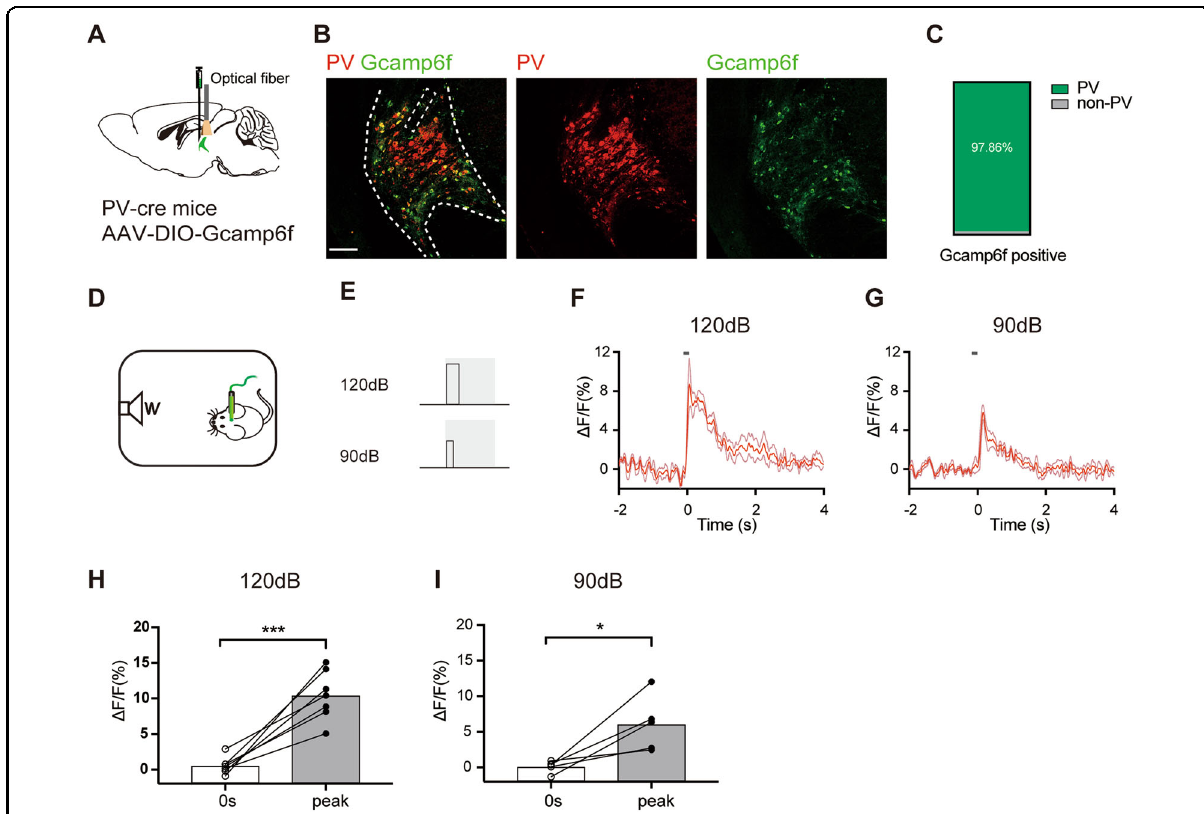
Fig. 2 Sound stimuli of PPI paradigm increases calcium activity of PV + neurons in audTRN. A Strategy of calcium activity recording of PV + neurons in audTRN. A Cre-dependent AAV for expression of Gcamp6f was bilaterally injected into the audTRN in PV-cre mice. B Left, example of confocal image showing overlap of Camp6f + neurons (green, right) and PV + neurons (red, middle). White dotted lines mark the border of the audTRN. Scale bar: 100 µm. C Quanti fi cation shows that approximately 97.86% of Gcamp6f cells are PV + ( N = 3 mice). D , E Schematic of calcium activity recording experiment. Mice were given sound stimuli by a speaker in a sound-proof chamber. The time duration of the sound stimulus was 40 ms (120 dB) and 20 ms (90 dB). F , G Examples of calcium responses in the audTRN when mice were given sound stimuli ( F , 120 dB; G , 90 dB). Thick lines indicate the average, and thin lines indicate the s.e.m. A short line (black) in each image indicates the sound stimulus period. H , I Sound stimuli of PPI paradigm Increased calcium activity in audTRN ( H , 120 dB, paired two-tailed t -test, t 6 = 6.723, P = 0.0005, N = 7 mice) ( I 90 dB, paired two-tailed t -test, t 4 = 3.273, P = 0.0307, N = 5 mice), * P < 0.05, *** P <